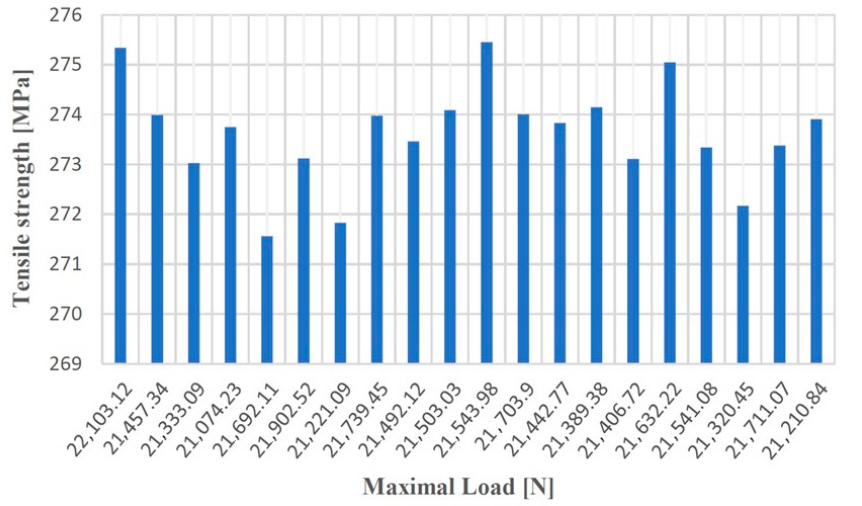
Figure 8. Tensile strength values according to the maximum forces applied to the 20 test samples made of cast iron with lamellar graphite type EN-GJL-250.